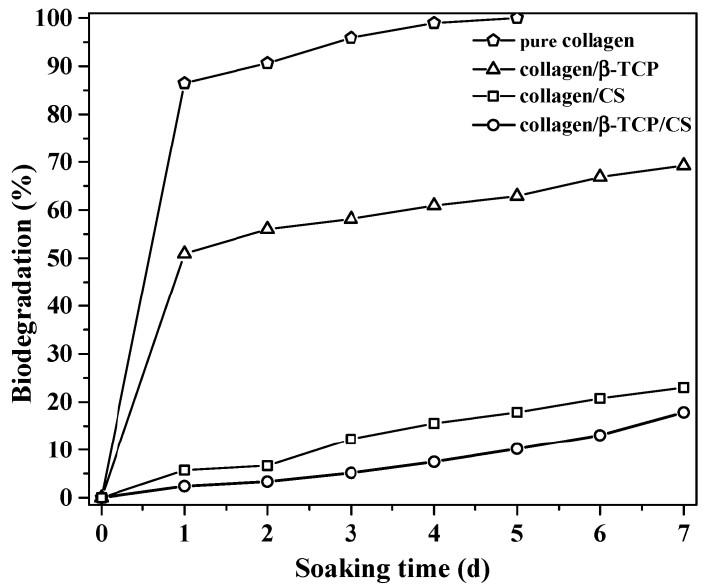
Figure 6. In vitro biodegradation of the pure collagen scaffold and collagen/ β -TCP, collagen/CS, and collagen/ β -TCP/CS composite scaffolds after soaking in citric acid solution for 7 d.